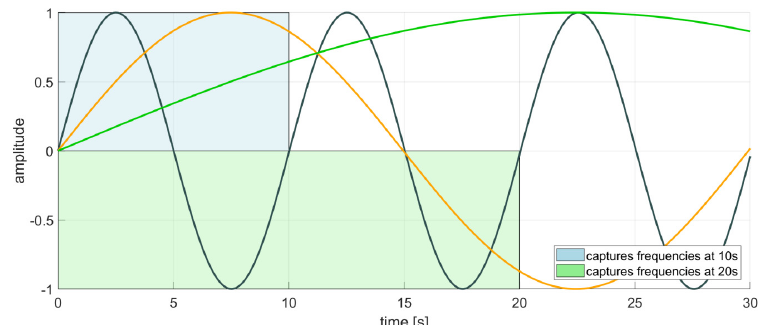
Figure 2. Representation of the temporal course of oscillations with different frequencies (0.1 Hz green; 0.01 Hz orange; 0.033 Hz black).